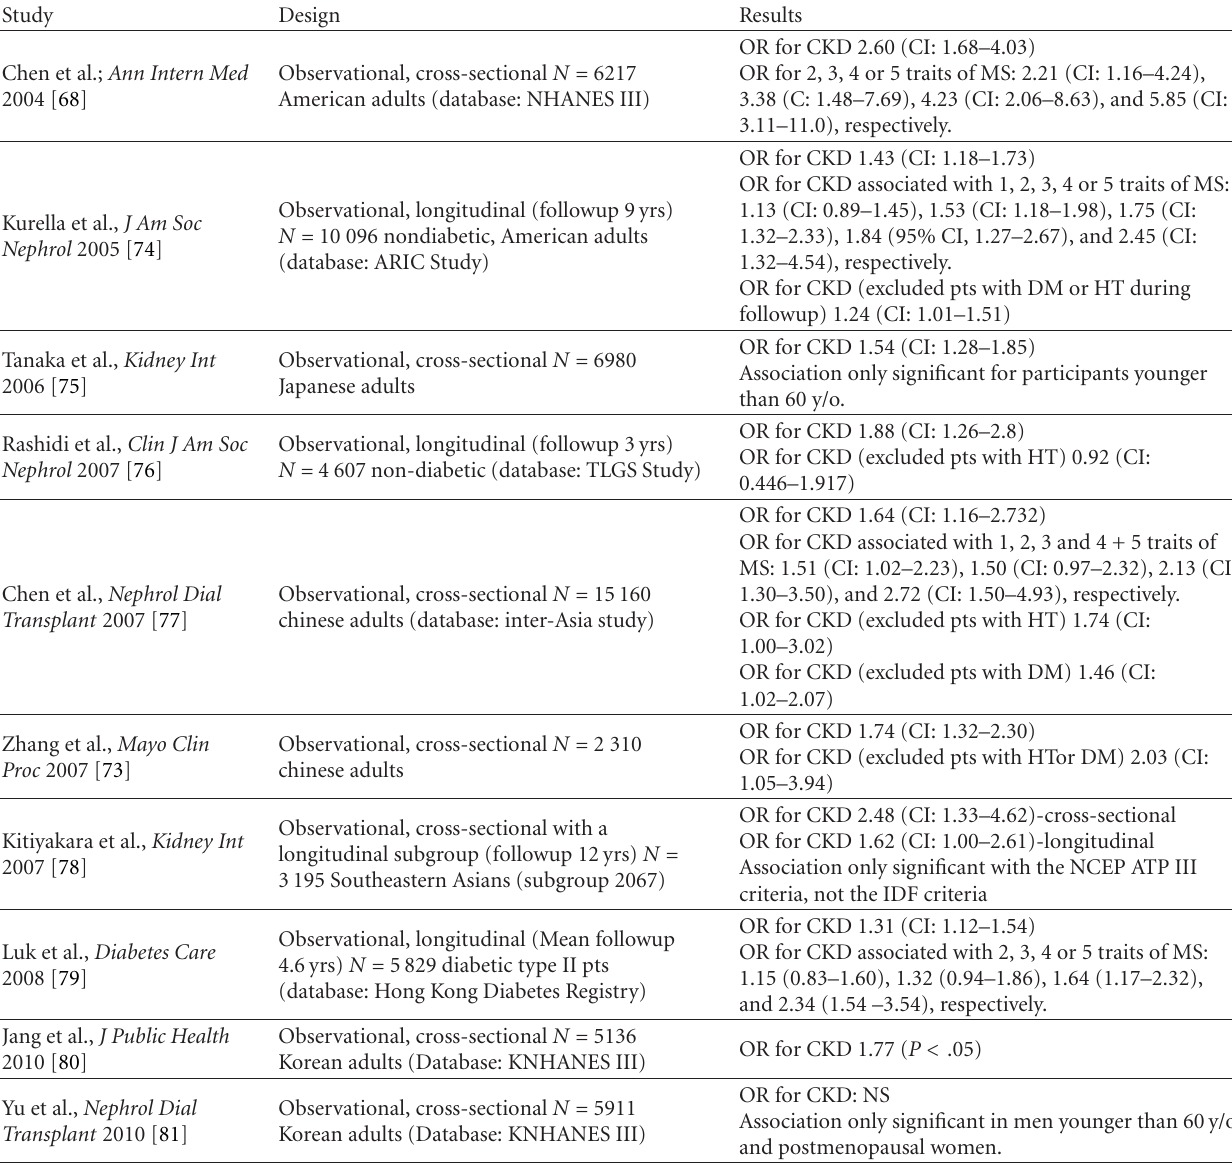
Table 2: Studies that evaluated the association between the metabolic syndrome and chronic kidney